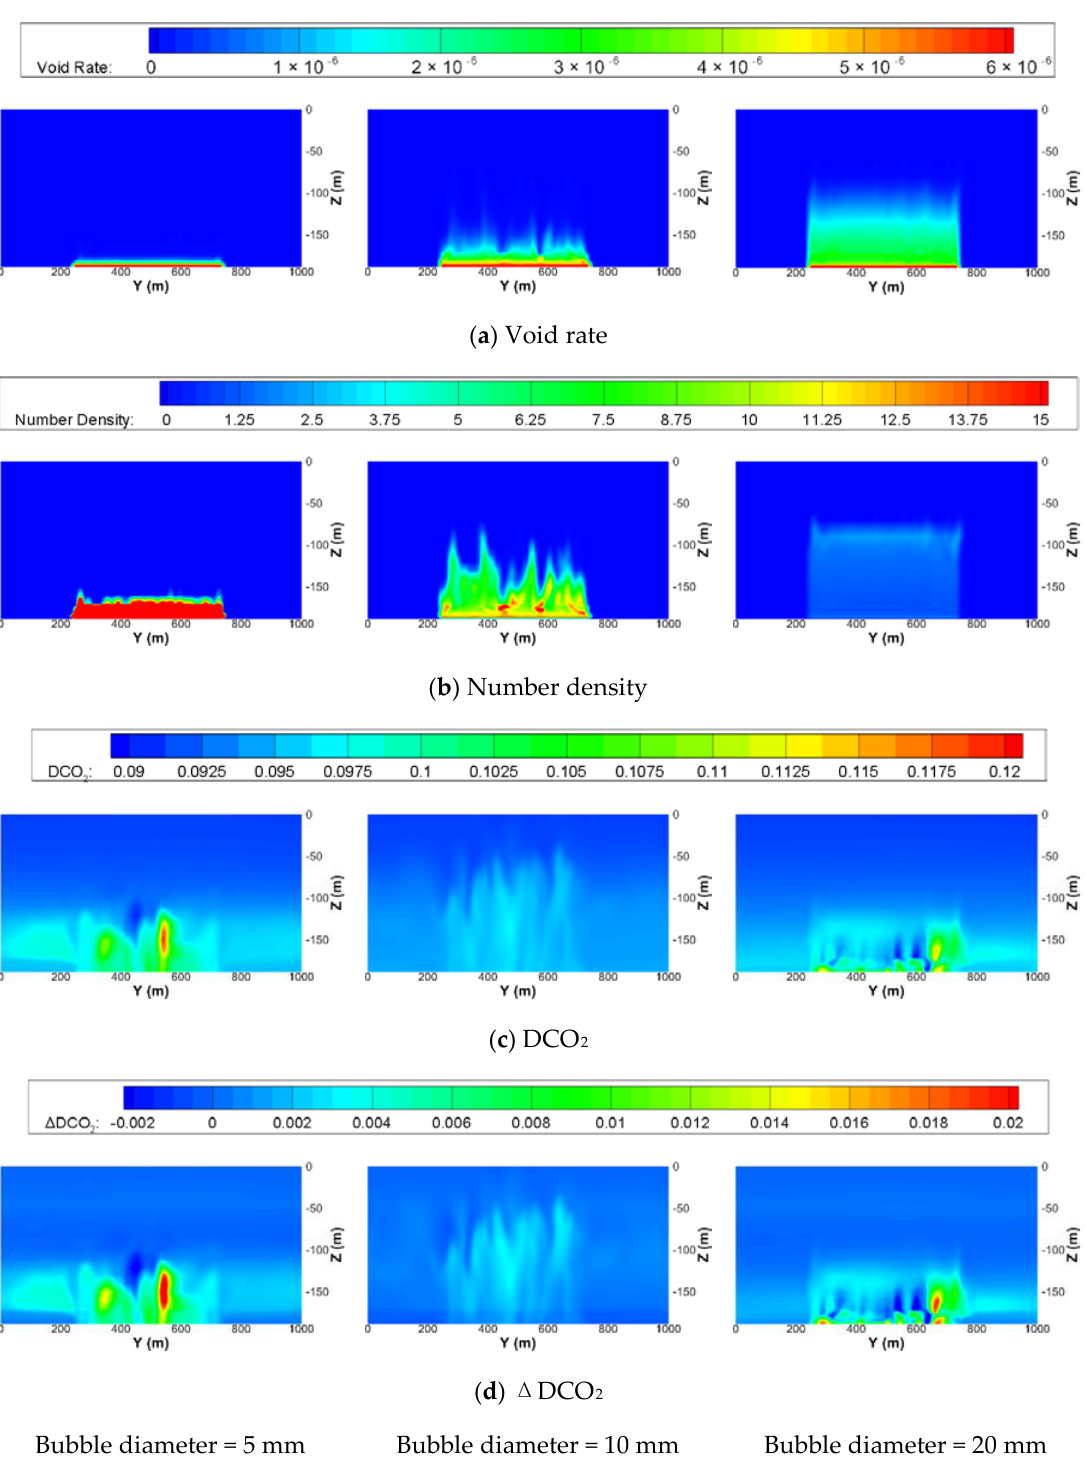
Figure 11. Contour maps of ( a ) void rate, ( b ) number density of undissolved CO 2 bubbles, ( c ) DCO 2 , and ( d ) ∆ DCO 2 on the center plane in the x direction (x = 1000 m) of the small-scale domain at 30 days after the start of leakage with the same leakage rates of 100,000 t / y and leakage area of 20,000 m 2 but different initial diameter of bubble.